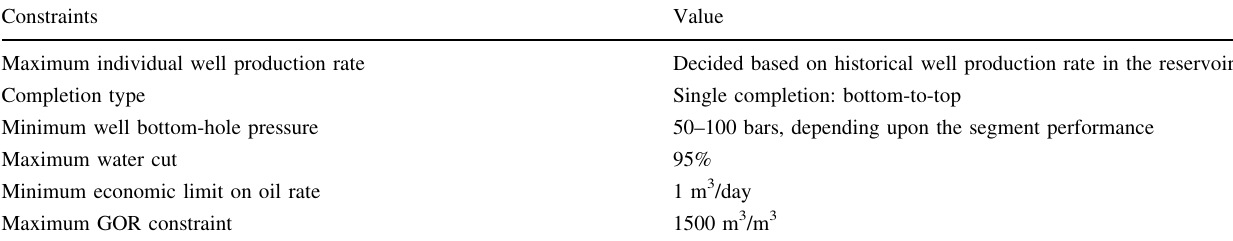
Table 5 Well-level constraints for prediction runs